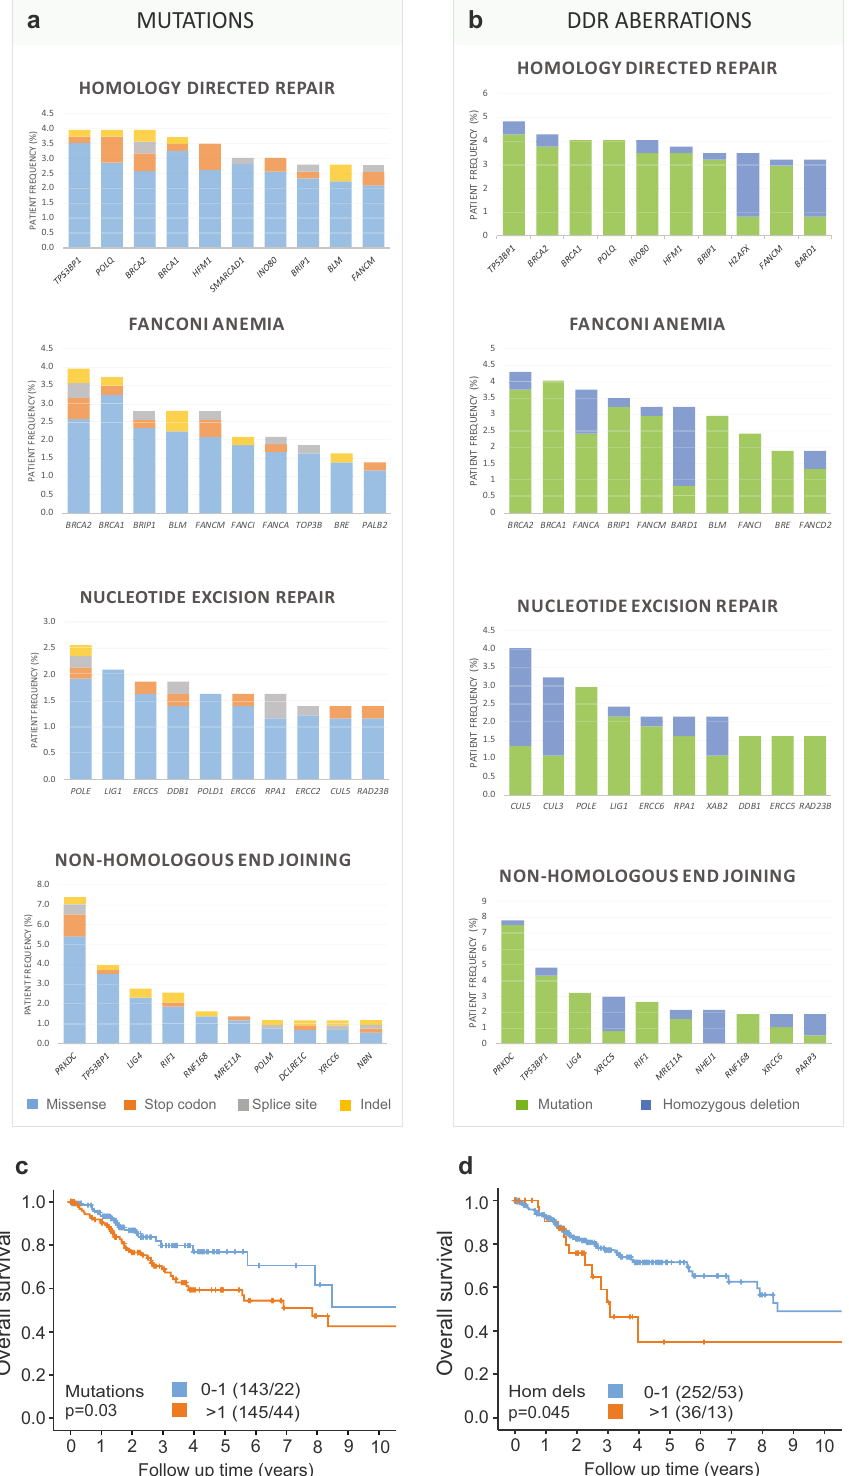
Fig. 5 Single-nucleotide mutation and homozygous deletion frequencies in major DNA damage repair groups. a , b The ten genes with the highest frequency of mutation (left) and mutation plus homozygous deletion (right) within four major DNA damage repair (DDR) groups. a Mutation frequencies in DDR genes across 430 cervical carcinomas. Total mutation frequencies include missense (blue), stop codon (orange), splice site (gray), and indels (yellow). b Frequencies of DDR aberrations including mutation (green) and homozygous deletion (blue) in 372 cervical carcinomas. Overall survival for cervical cancer patients in relation to the total number of mutations ( c ) and homozygous deletions ( d ) in DDR genes are represented by Kaplan – Meier curves with probability values for Mantel – Cox log-rank test that compares categories. The number of patients and events are given in parentheses (patients/events). Hom dels homozygous